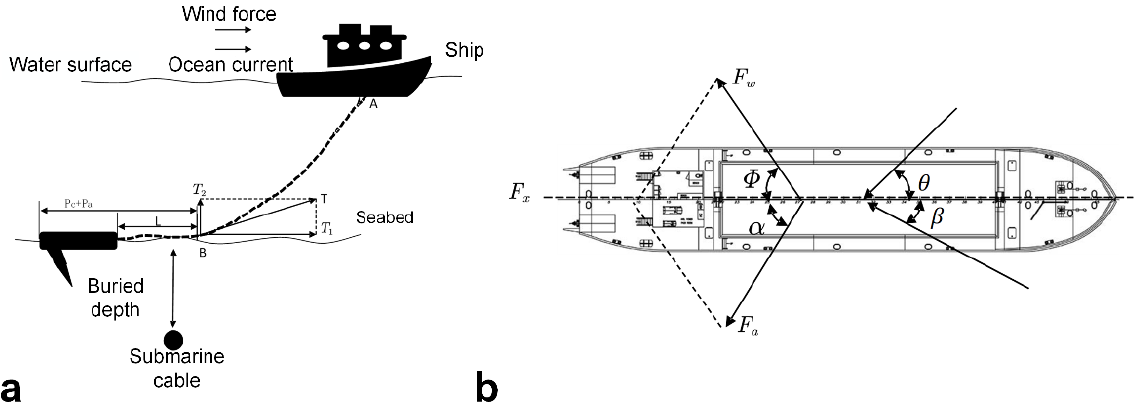
Figure 3. ( a ) The force acting on the ship and anchor when anchored. ( b ) The wind and hydrodynamic forces on the ship.